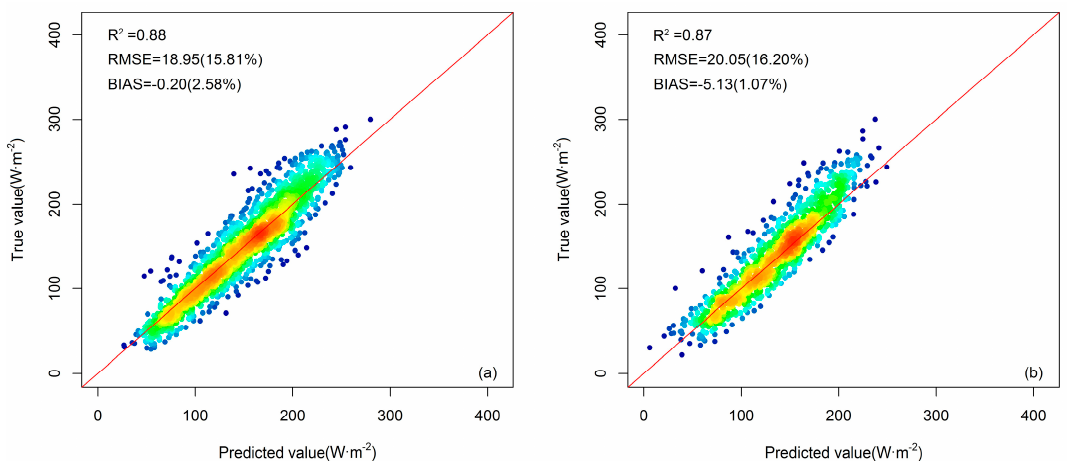
Figure 12. ( a ) Evaluation results of the training set’s estimated monthly mean DSR based on the ANN-based DSR model against ground measurements in 2001 and 2002. ( b ) Evaluation results of the validation set’s estimated monthly mean DSR based on the ANN-based DSR model against ground measurements in 2003. The number in the parentheses is the percent bias or RMSE value.